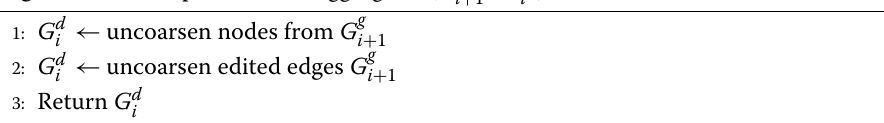
(cid:5) , G d i i + 1